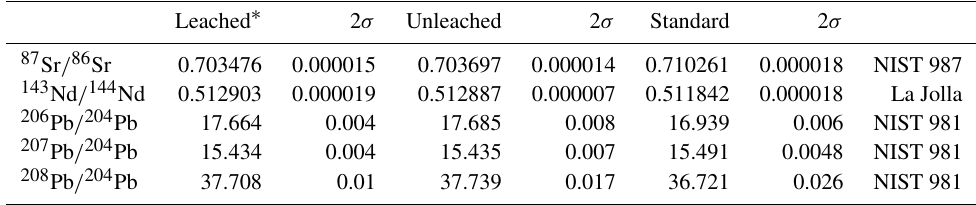
Table 2. Isotopic compositions for basalt from the Seifu Seamount. Leached ∗ 2 σ Unleached